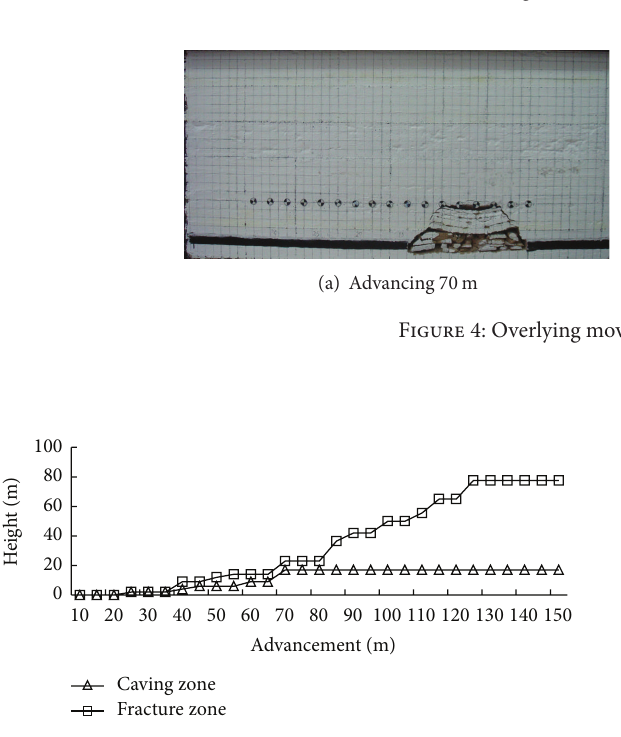
Figure 3: Model design and measurement point arrangement.